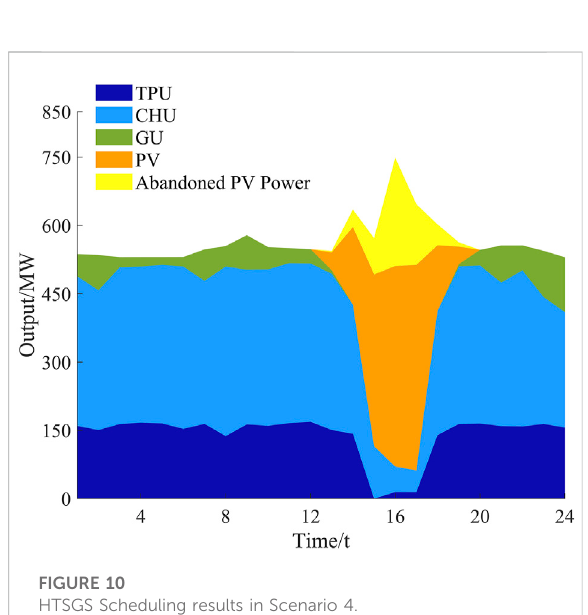
FIGURE 9 HTSGS Scheduling results in Scenario 3.